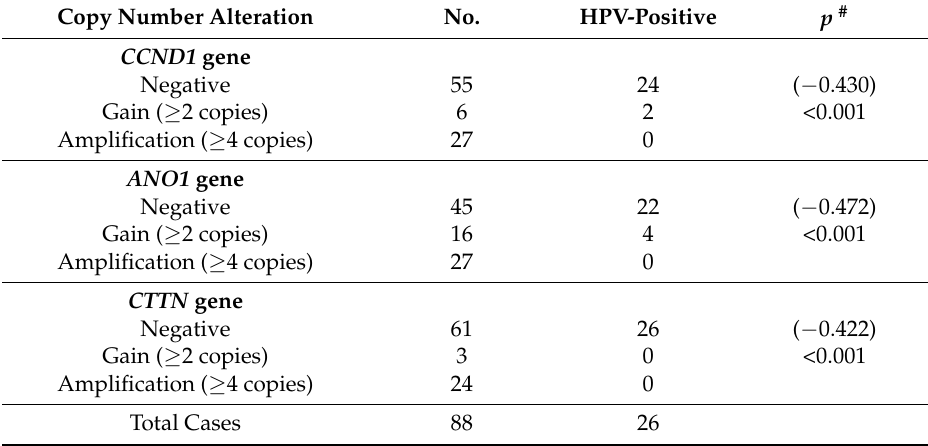
Table 2. Analysis of CCND1, ANO1 , and CTTN gene gain and amplification in relation to HPV status in 88 HNSCC patients.